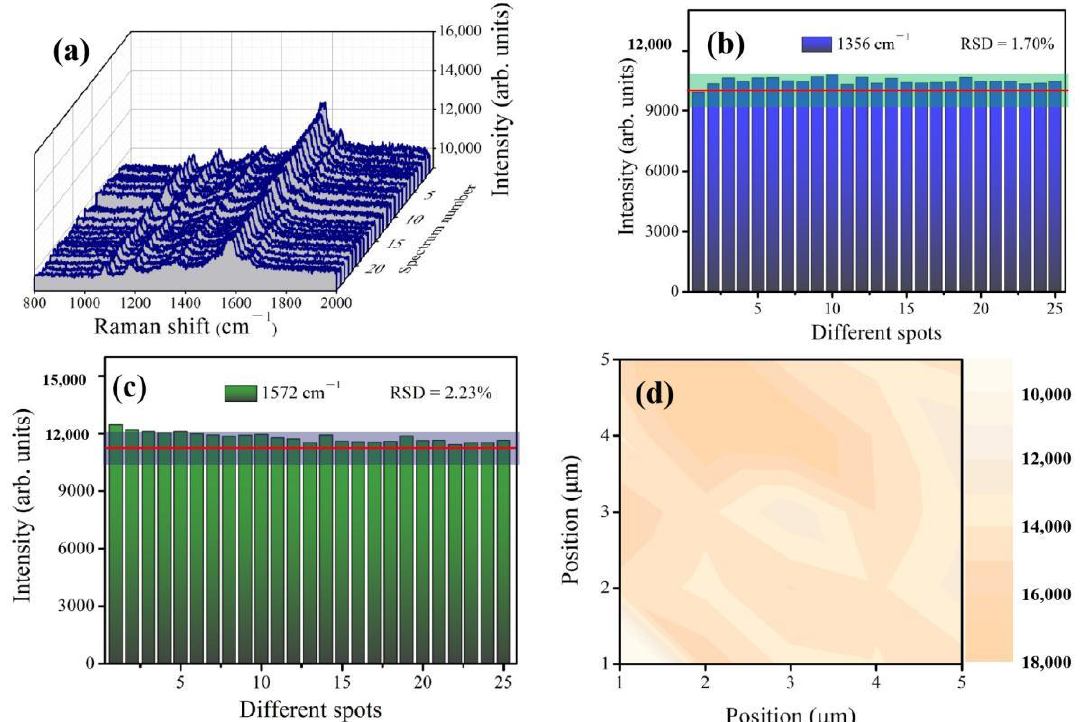
Figure 9. ( a ) SERS spectra of 10 −10 mg/mL acephate obtained from 25 randomly selected spots; ( b , c ) Raman characteristic peak intensities of 10 −10 mg/mL acephate; ( d ) SERS mapping image of the 1181 cm −1 characteristic peak.